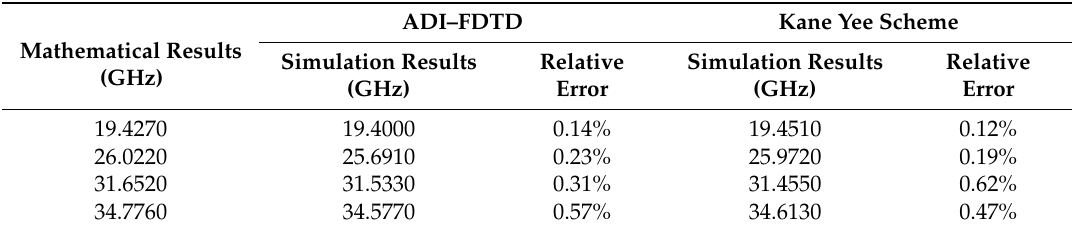
Table 1. Comparison of the homogeneous waveguide results of the Yee FDTD and ADI-FDTD methods.